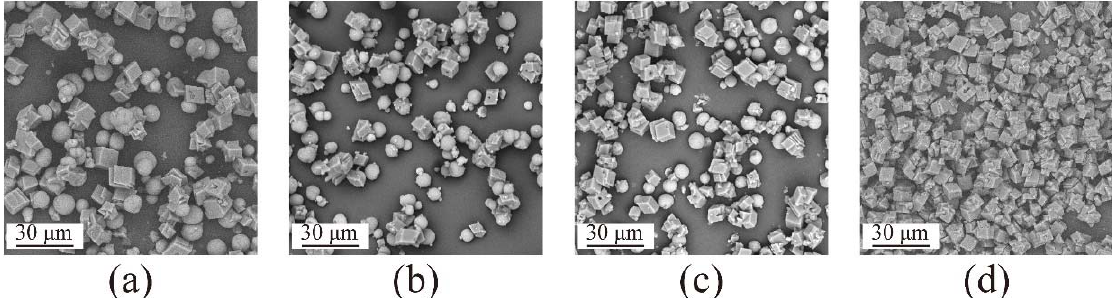
Figure 9. Mass fraction of the calcite (W calcite /W calcite+vaterite ) as a function of the concentration of nanobubbles in deionized water after 4 h, group 1 ( a ), group 2 ( b ), group 3 ( c ), group 4 ( d ).